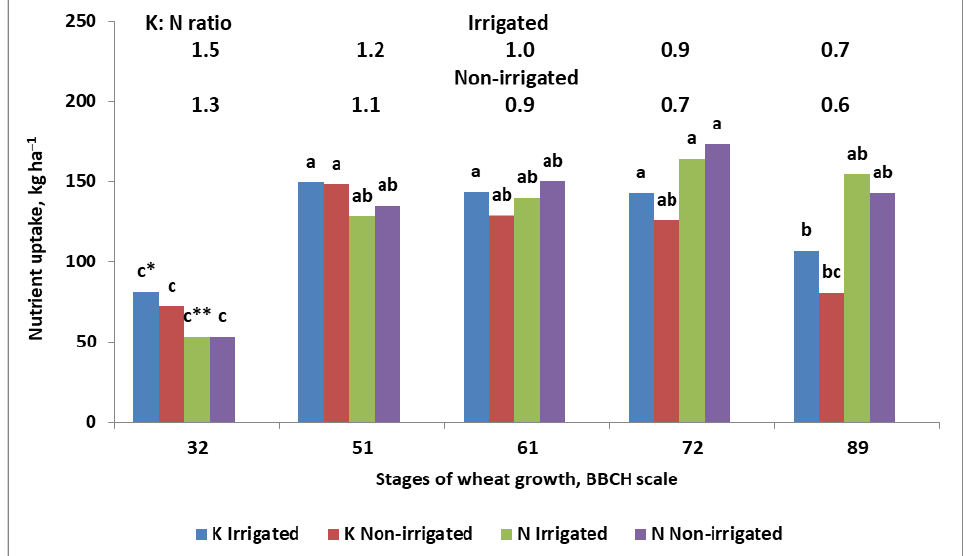
Figure 5. Nitrogen (N) and potassium (K) accumulation by winter wheat in critical stages of yield formation under various water conditions; means of three growing seasons (Grzebisz, not published). Legend: The different letters indicate significant differences between the treatments ( p ≤ 0.05); * irrigation and ** non-irrigation conditions of wheat cultivation, respectively; K, N, potassium and nitrogen, respectively.